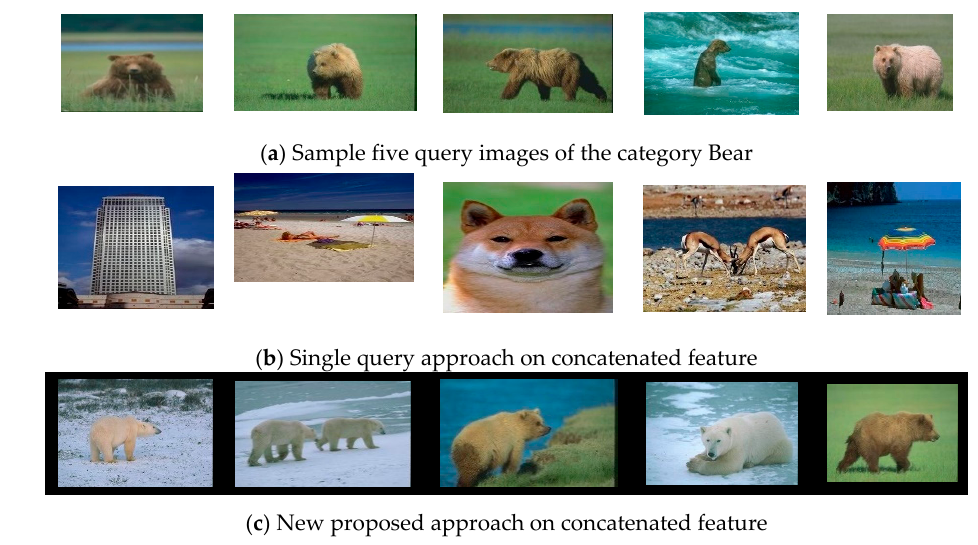
Figure 1. Retrieval results of the sample query for the category “bears” using concatenated features. ( a ) The 5 query images, ( b ) the corresponding retrieval result using a single query approach (only the first query image is used), and ( c ) the corresponding retrieval result using the proposed approach.